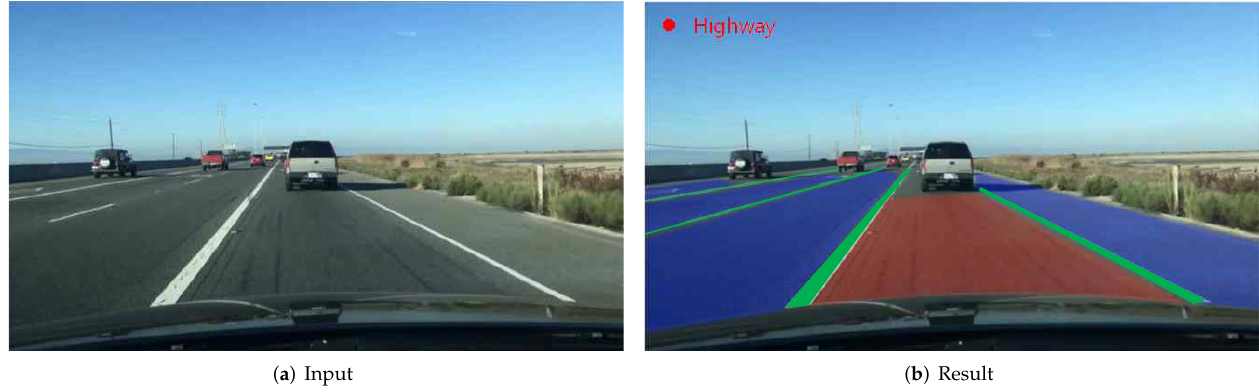
Figure 1. Our goal: Solving drivable area estimation, lane line segmentation, and scene classification through multi- task